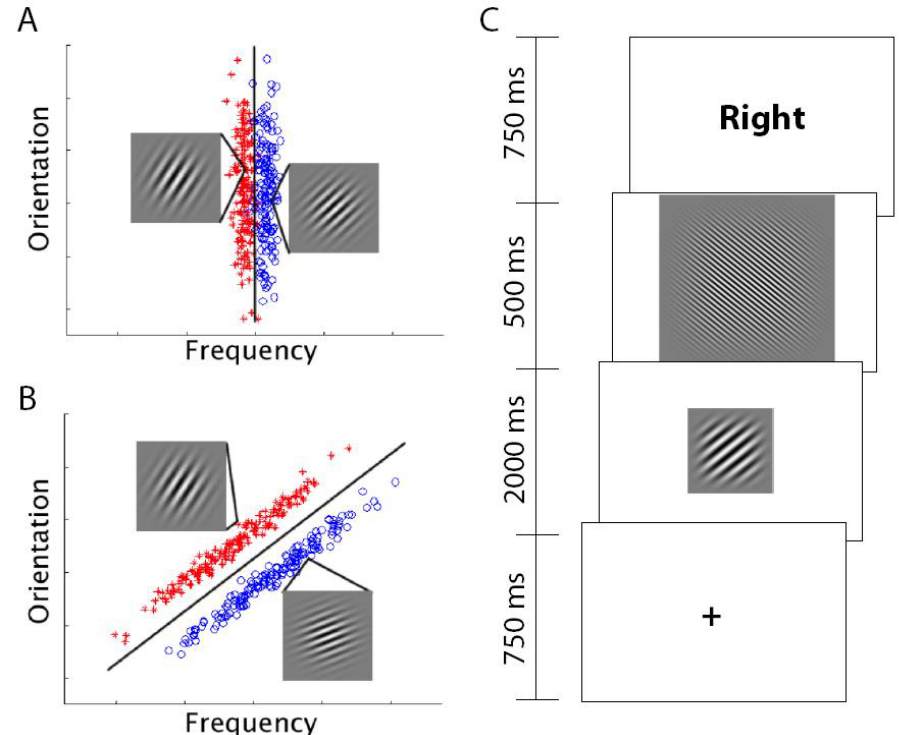
Figure 1. RB ( A ) and II stimuli ( B ). Each point represents a distinct Gabor patch (sine-wave) stimulus defined by orientation (tilt) and frequency (thickness of lines). In both stimulus sets, there are two categories (red and blue points). RB categories are defined by a vertical boundary (only frequency is relevant for categorization) whereas II categories are defined by a diagonal boundary (both orientation and frequency are relevant). In both RB and II stimuli there are examples of a stimulus from each category. ( C ) Schematic of a single trial. A fixation point is followed by the to-be-categorized-stimulus (either RB or II depending on the subject), then a short visual mask that is followed by the feedback. The subject responded “category A” or “category B” during the 2 s the stimulus was on the screen using hand-held buttons. The length of the inter-trial interval (ITI) was pseudorandom and based on between zero and five 4-s “fixation-only” trial periods arranged to maximize the separability of the measured hemodynamic response to stimulus